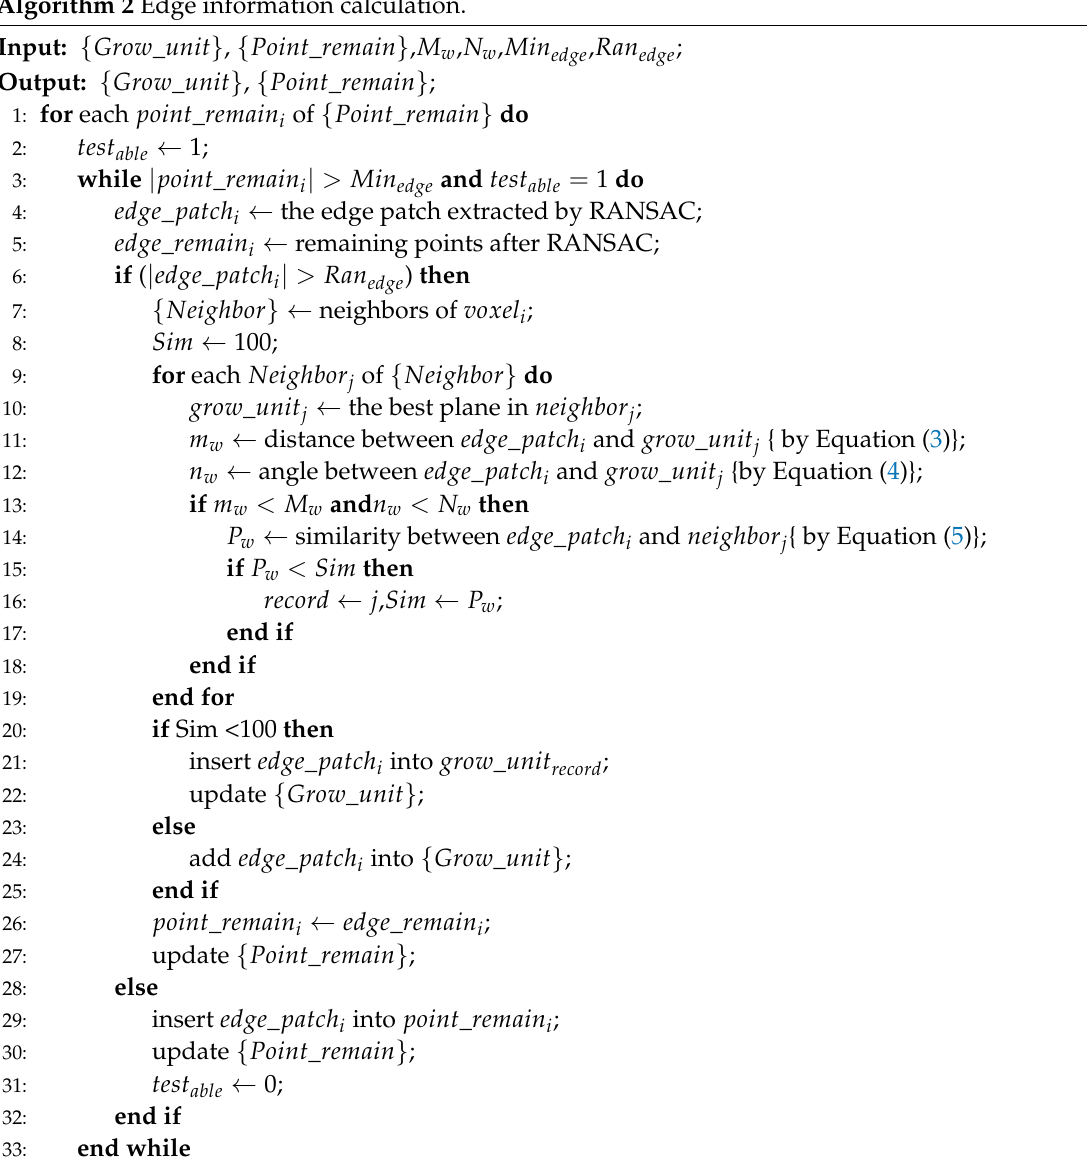
Algorithm 2 Edge information